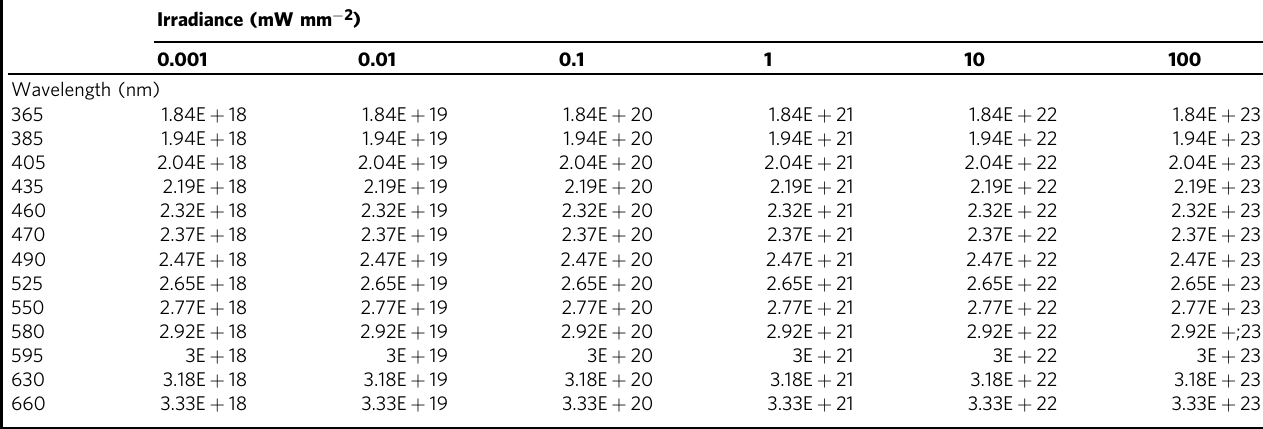
Table 2 Photon fl ux given as a number of photons s − 1 m − 2